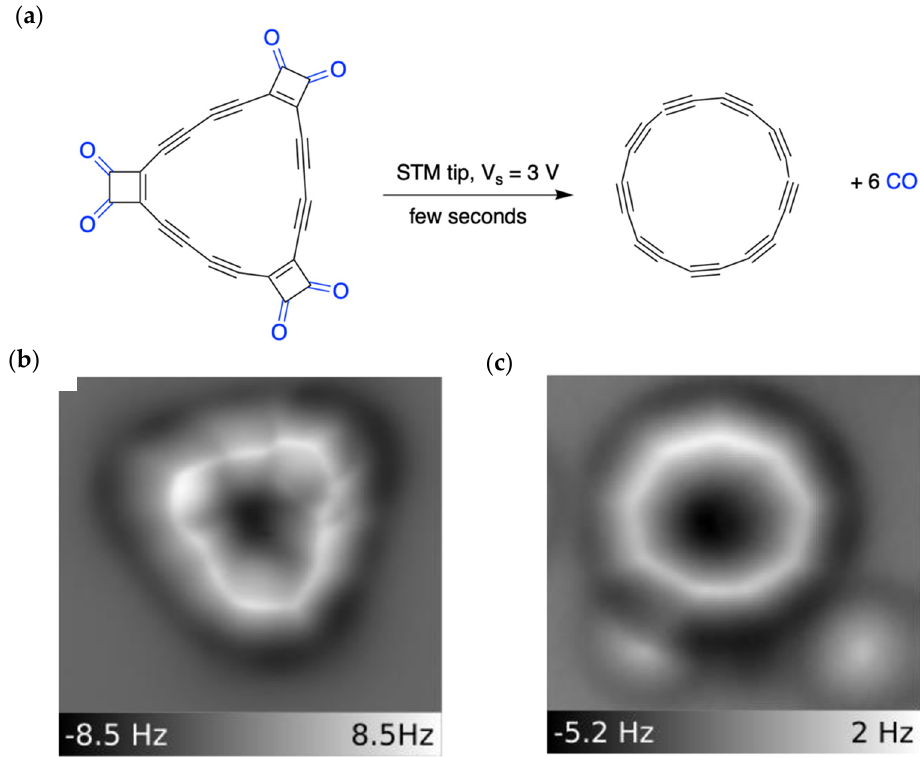
Figure 3. ( a ) Synthesis of cyclo[18]carbon by using STM tip to inject electrons and induce decarbonylation of cyclocarbon oxide adsorbed onto a NaCl bilayer deposited on Cu(111). ( b ) AFM image of cyclocarbon oxide at 5 K. ( c ) AFM image of cyclo[18]carbon at 5 K.